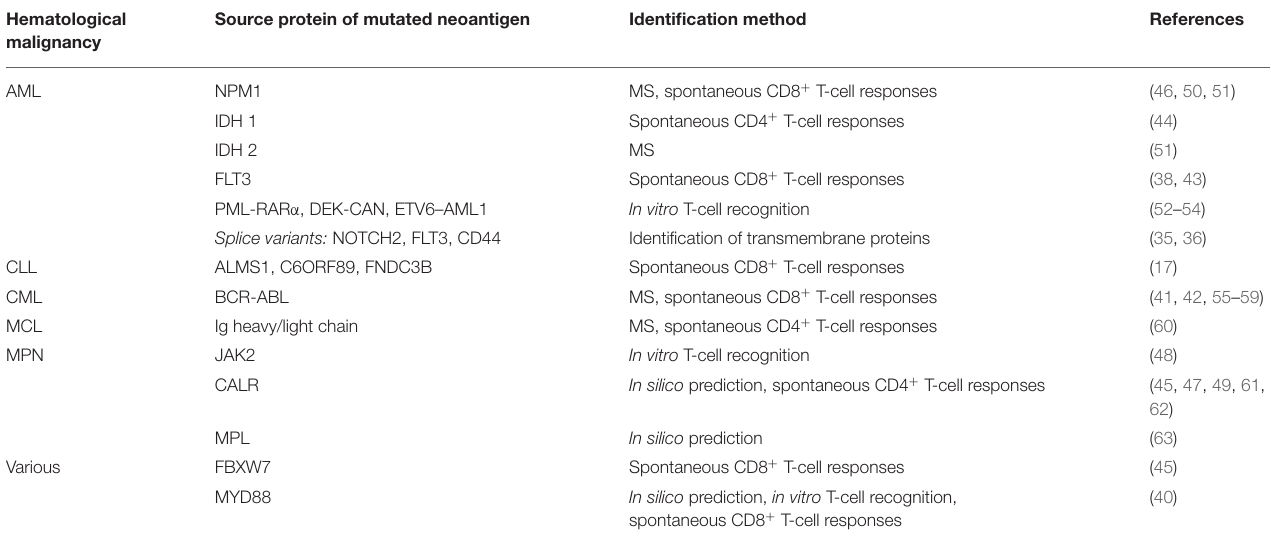
TABLE 1 | Overview of neoantigens in hematological malignancies. Hematological